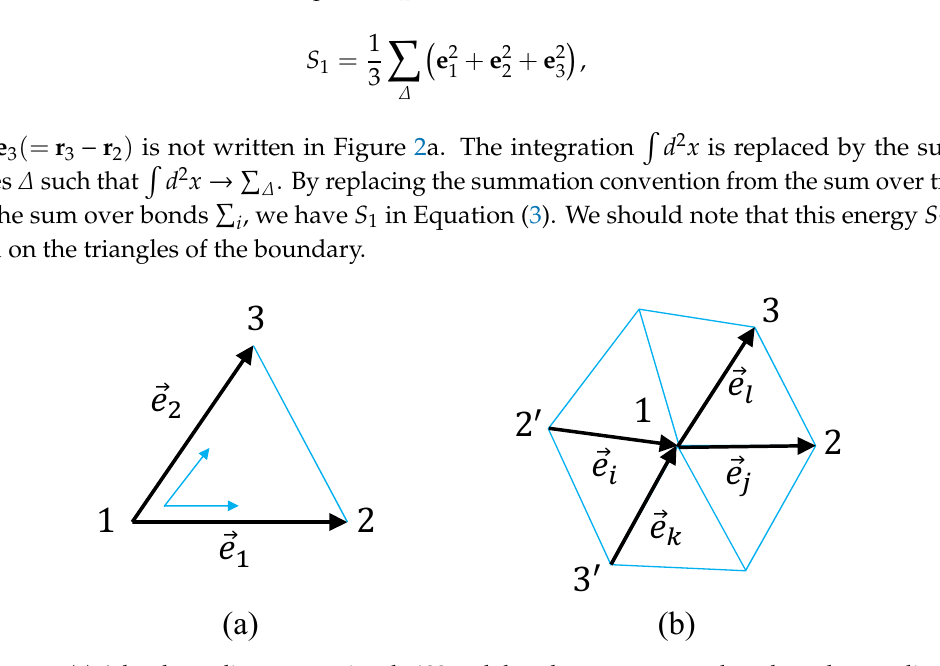
Figure 2. ( a ) A local coordinate on a triangle 123 and the edge vectors e 1 and e 2 along the coordinates axes x 1 and x 2 . A local coordinate for the discretization of the second-order di ff erential ∂ 2 r in S 2 of LG model on ( b ) a vertex of coordination number q = 6